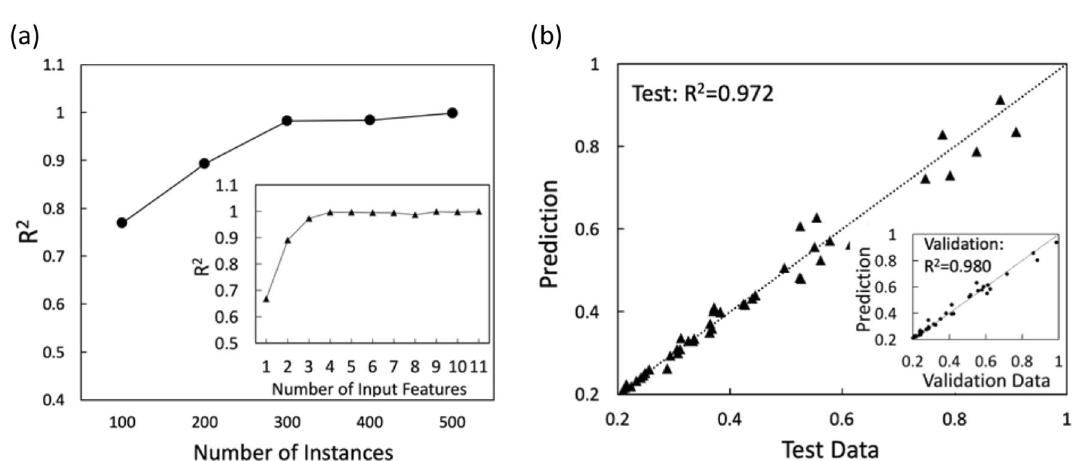
Figure 4. ( a ) ANN predictions (R 2 ) as a function of the number of instances. Inset: the impact of the number of input features on ANN predictions using 300 instances. Features are removed one by one starting from the least important feature; ( b ) the testing and validation performance (inset) of ANN predictions using the three pores structural features from 300 instances. The values represent normalized reaction